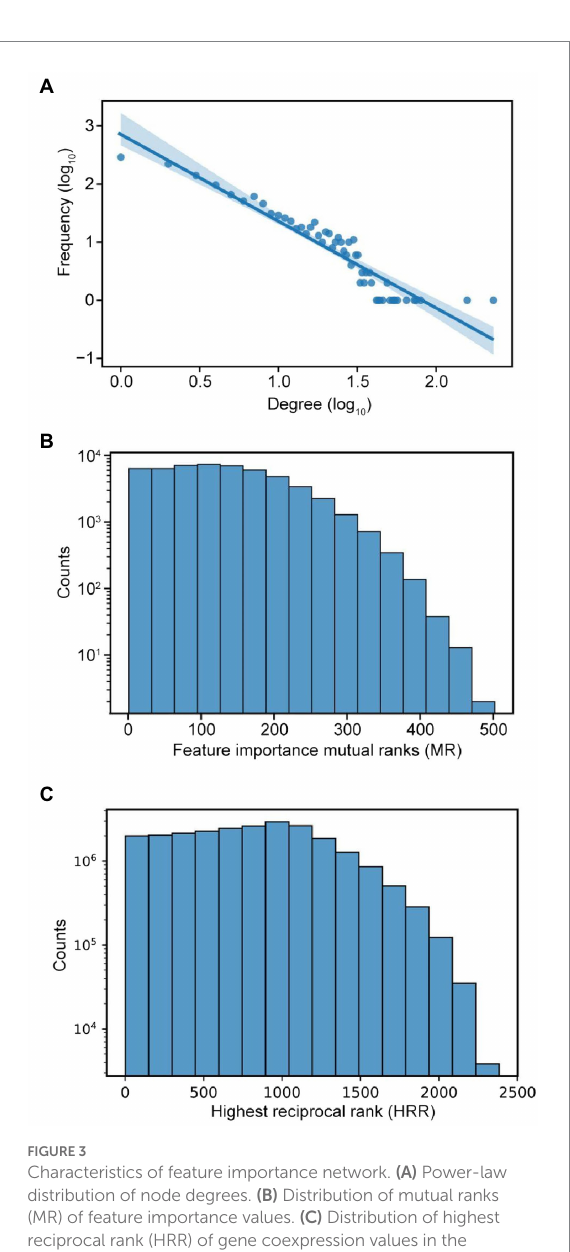
FIGURE 3 Characteristics of feature importance network. (A) Power-law distribution of node degrees. (B) Distribution of mutual ranks (MR) of feature importance values. (C) Distribution of highest reciprocal rank (HRR) of gene coexpression values in the coexpression network used in our study.